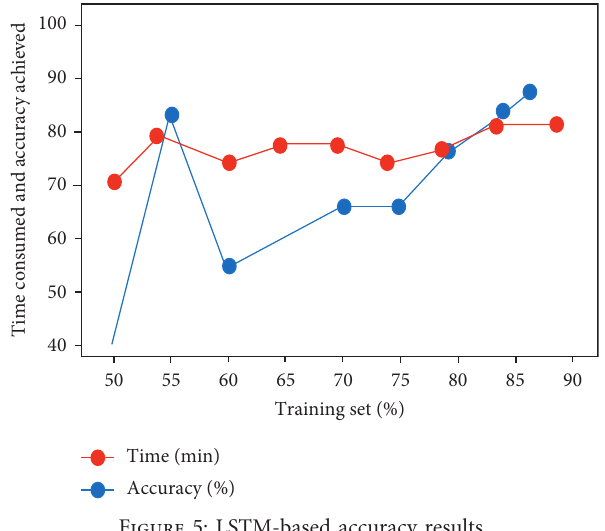
Figure 5: LSTM-based accuracy